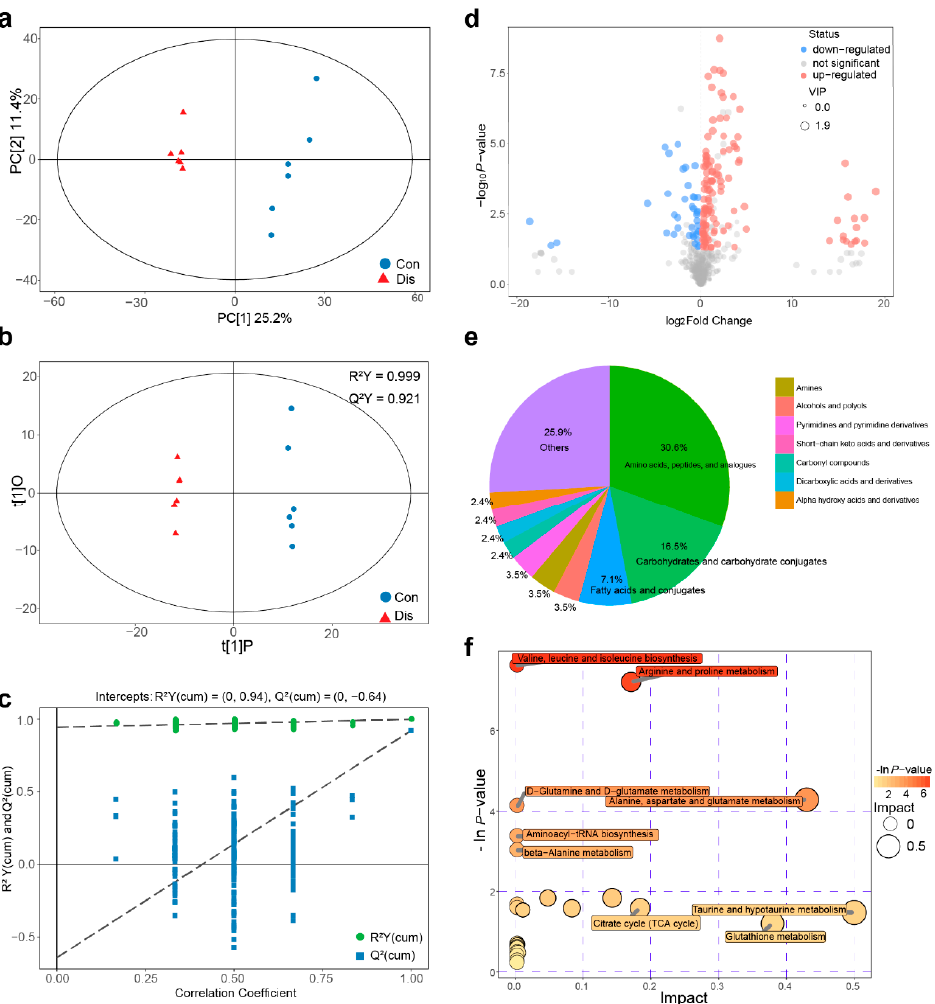
Figure 2. NIBV infection altered metabolic profiling in chicken kidneys. ( a ) Metabolic profile the Con and Dis groups visualized by principal component analysis (PCA). The points represent the scores of biological replicates. ( b ) Metabolic profiles of the Con and Dis groups visualized by orthogonal projections to latent structures–discriminate analysis. The abscissa t [1] P represents the predicted principal component score of the first principal component, the ordinate t [1] O represents the orthogonal principal component score, and the scatter shape and colour represent di ff erent experimental groups. ( c ) Permutation test of orthogonal projections to latent structures-discriminate analysis (OPLS-DA) model for groups Dis vs. Con. ( d ) Volcano plot of di ff erential metabolites, each point represents a metabolite and the point size represents the VIP value. ( e ) The category of the di ff erential metabolites. ( f ) Pathway analysis for groups Dis vs. Con; each bubble in the bubble diagram represents a metabolic